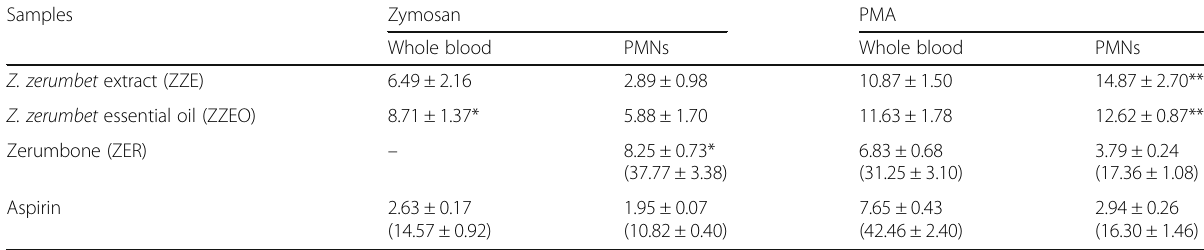
Table 4 IC 50 values ( μ g/mL) of ROS inhibitory activity of tested samples on human whole blood and PMNs